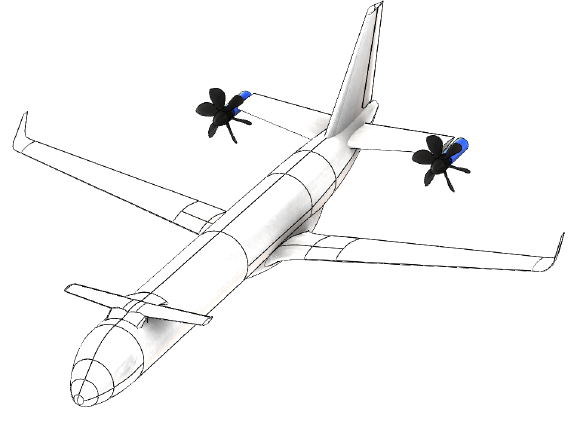
Figure 1. An illustration of the scaled aircraft model [11] with rear-mounted